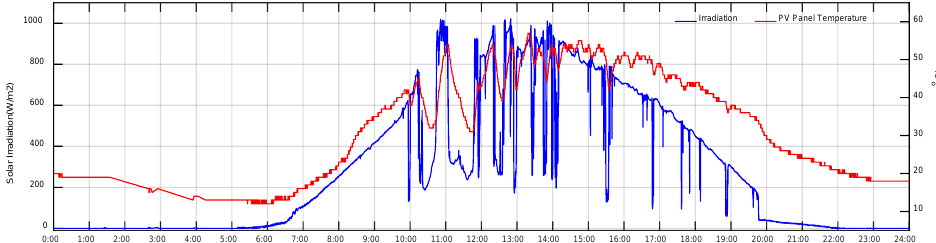
Figure 6. Weather data on the 20th June 2018 in Compiegne, France.